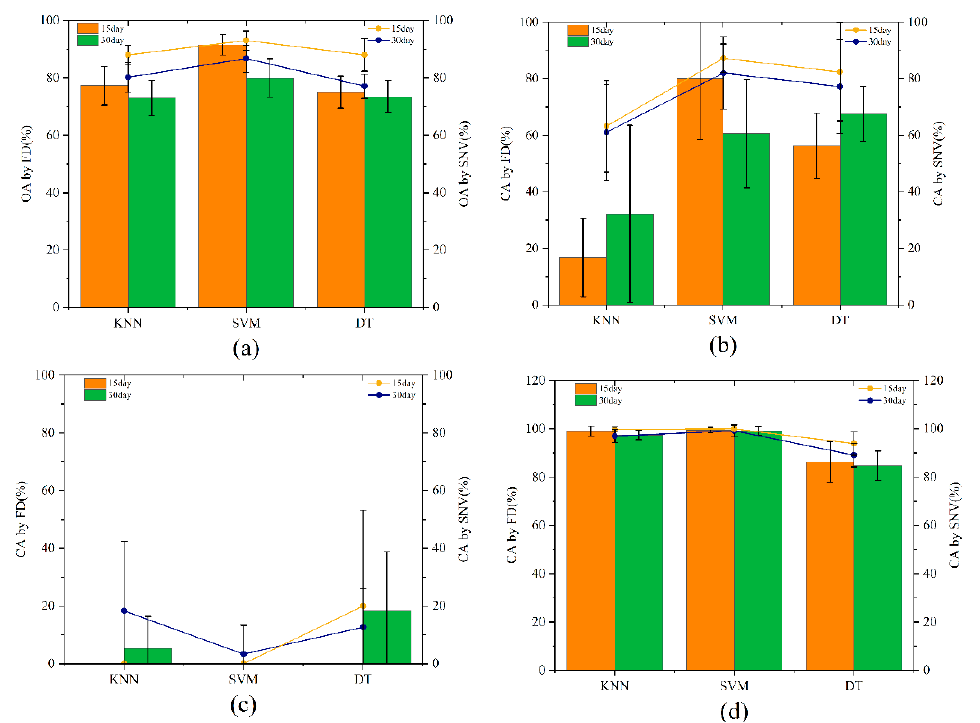
Figure 4. OA ( a ) and CA ( b – d ) modeled based on PCA.